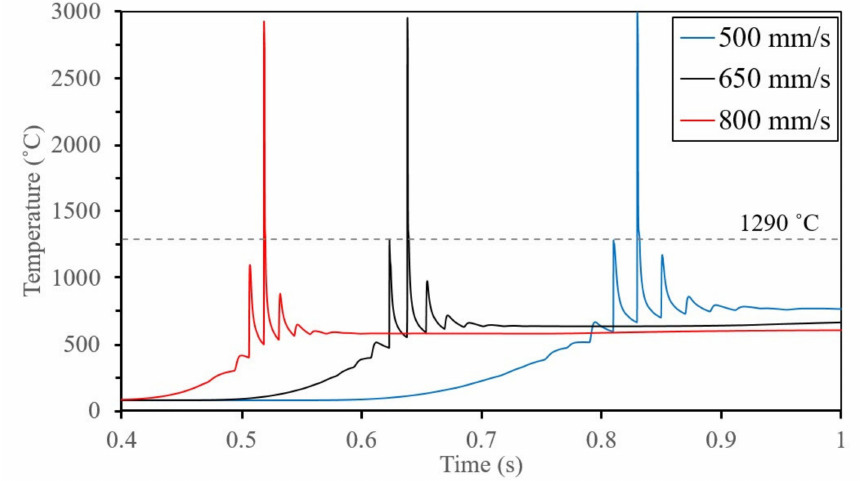
Figure 23. Temperature history for different scan speeds at 220 W and 0.12 mm.